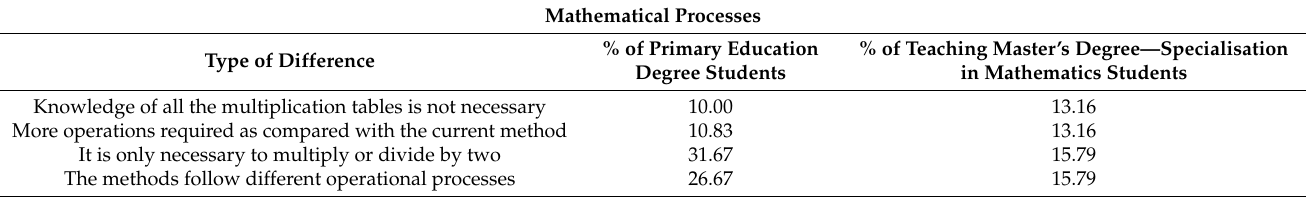
Table 3. Differences found between the degree and master’s students regarding the mathematical processes in the multiplication methods.